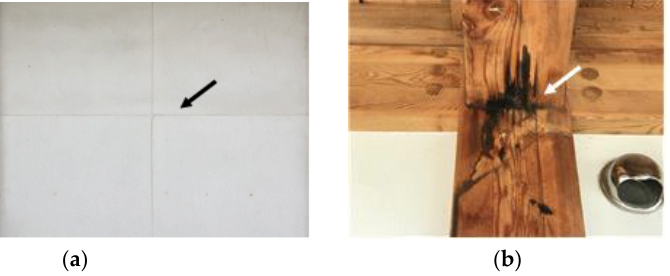
Figure 9. Hanok defects: parallel twists and joint fissures. ( a ) Wall cracks; ( b ) Adhesive elution